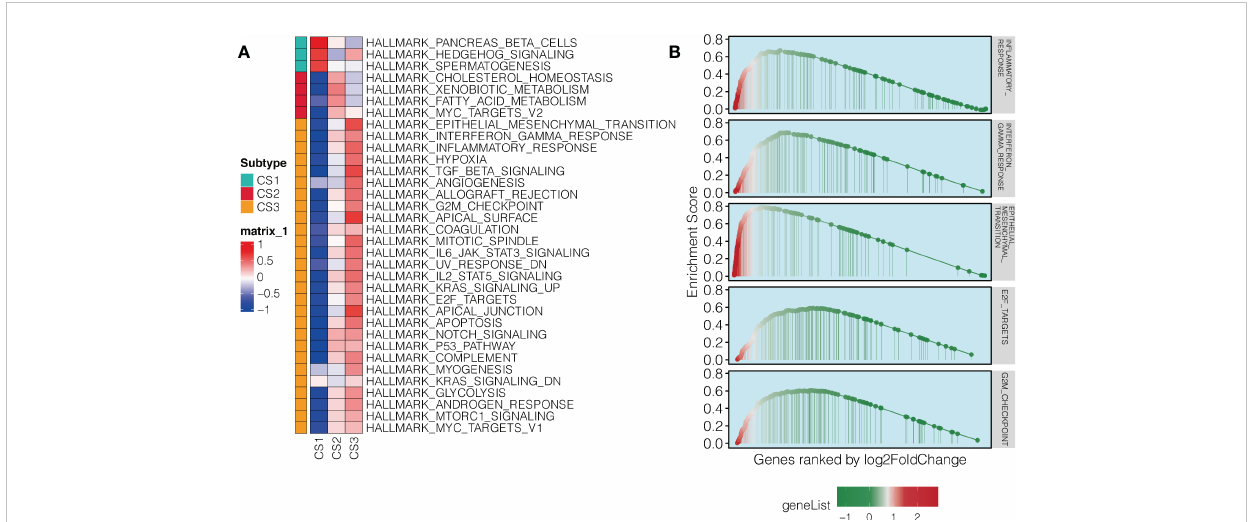
FIGURE 3 Pathway enrichment in the aggressive NAT10-relevant PDAC subtype. (A) Heatmap showing signi fi cantly and uniquely upregulated Hallmark pathways in each of the three NAT10-relevant PDAC subtypes; the input was the GSVA enrichment score of the speci fi c pathway in speci fi c subtype. (B) GSEA plot for immune-related and cell cycle-related pathways in the aggressive C3 subtype of PDAC in TCGA